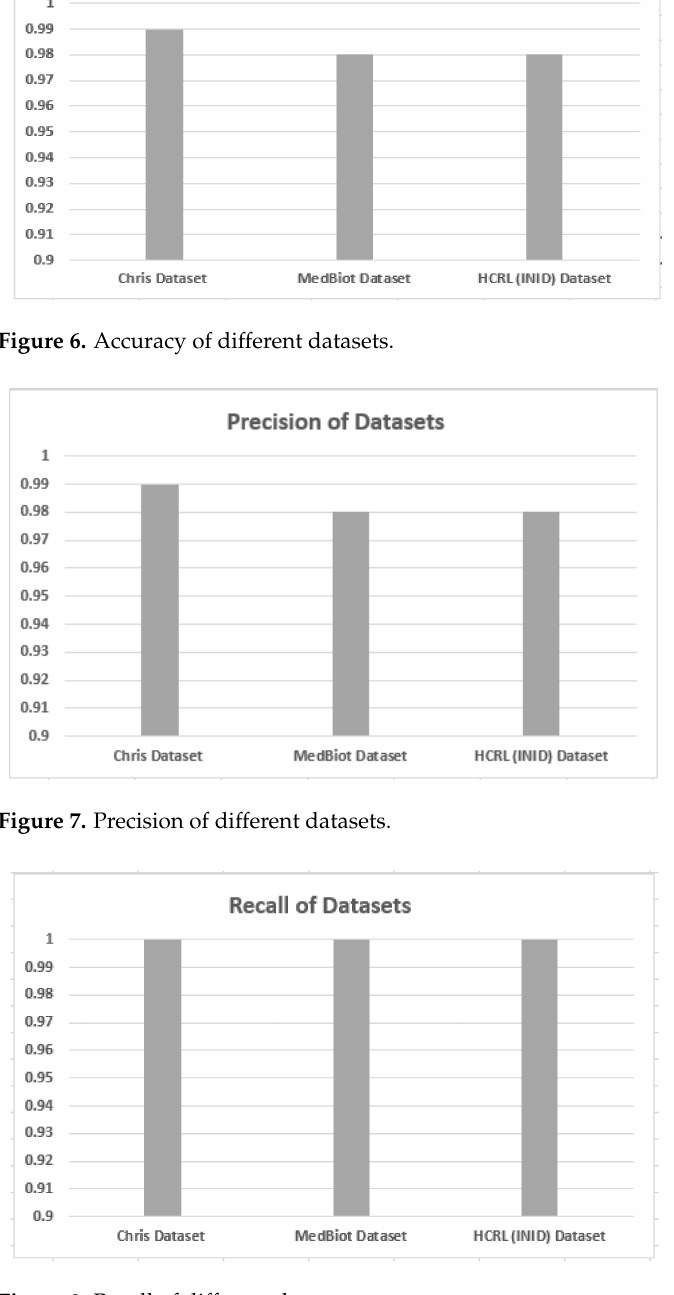
Figure 8. Recall of different